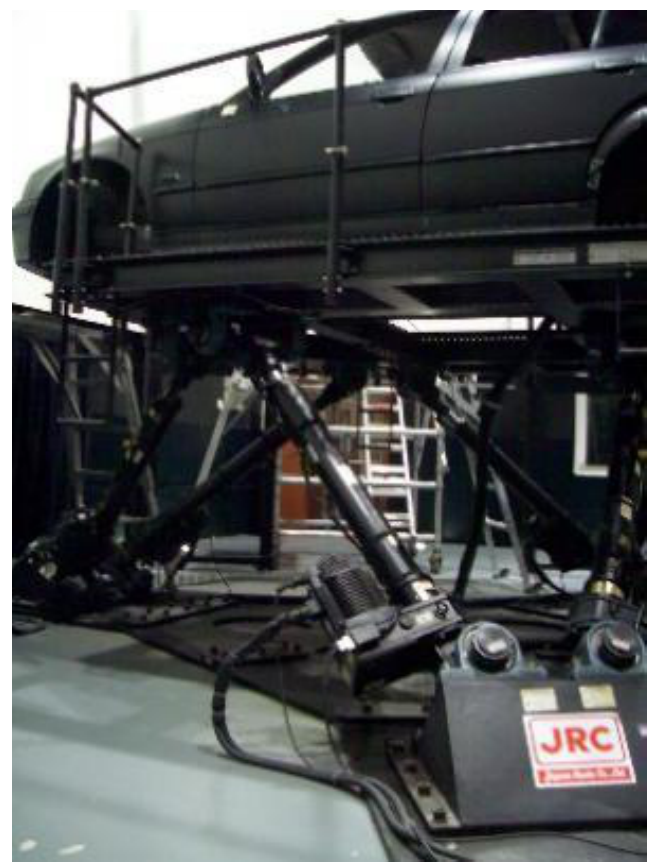
Figure 1. Driving simulator.